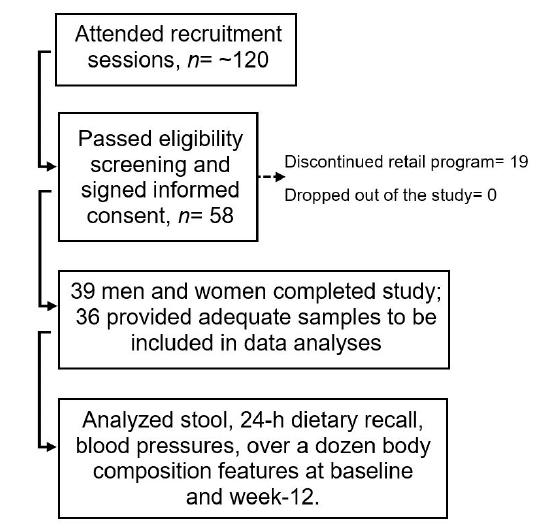
Figure 1. Schematic chart showing participant recruitment in the study.